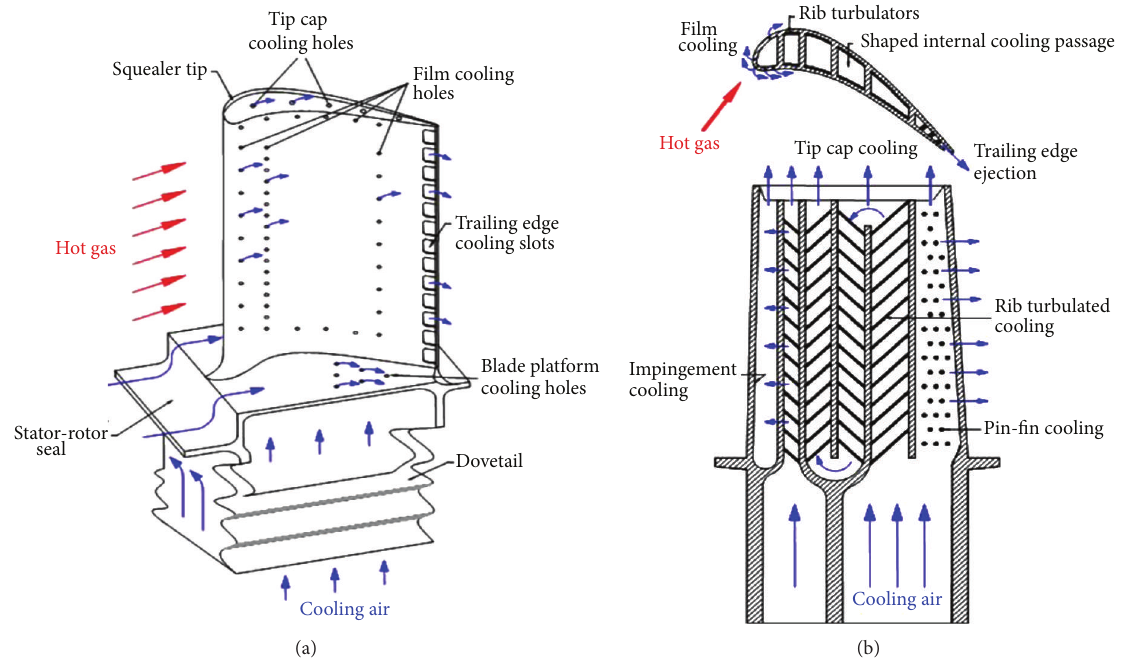
Figure 1: Gas turbine blade cooling schematic: (a) external cooling and (b) internal cooling.